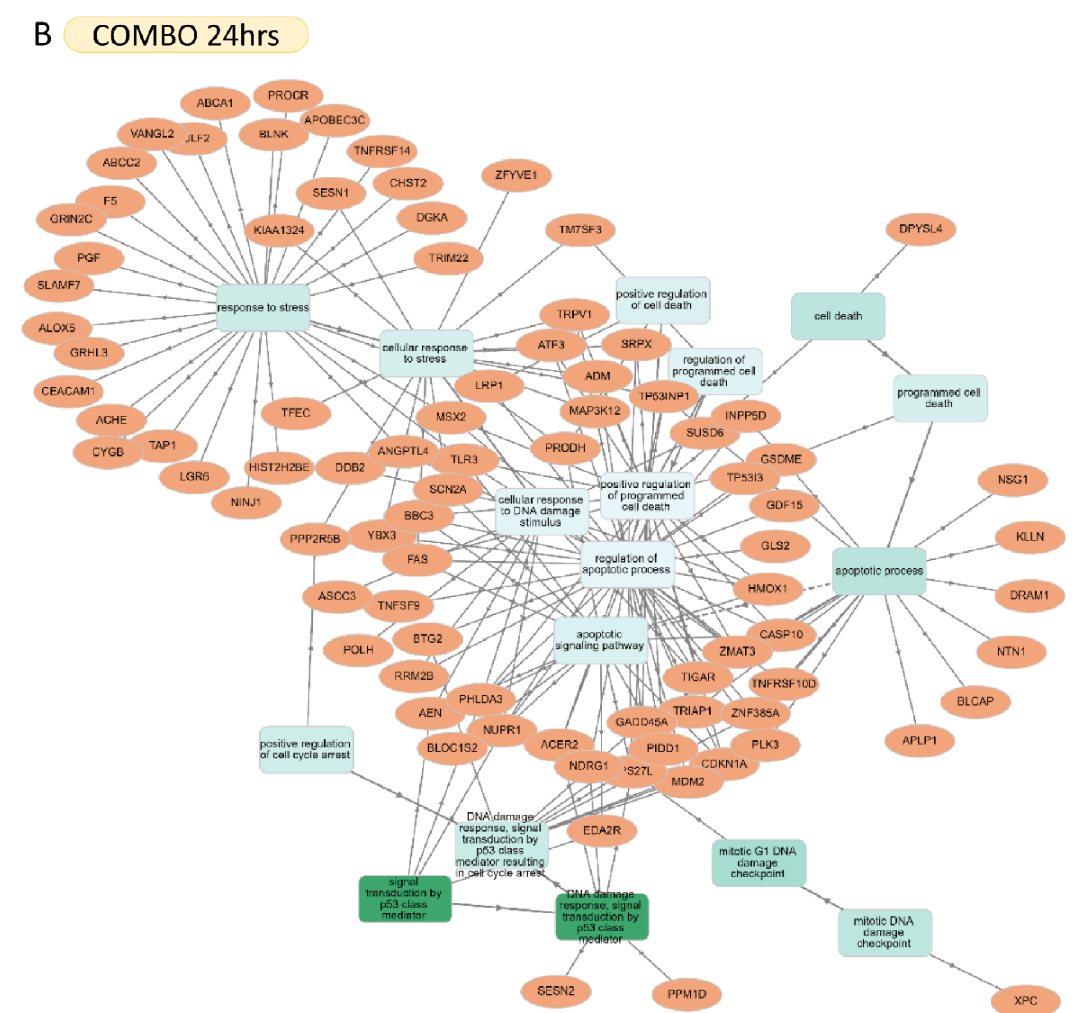
Figure 6. Comparative transcriptomic analyses between treatment with HDM201 alone and in combination with WIP1i (COMBO) for 6 and 24 h in RBE cells. ( A ) Venn diagram of all (left), upregulated (middle), and downregulated (right) differentially expressed genes, as selected according to a >2-fold change and p < 0.05. ( B ) REB was treated with HDM201 and GSK2830371 for 24 h. Seventy-seven differentially expressed genes with fold change ≥ 2 were analyzed by gene ontology (GO) enrichment analysis with Database of Immune Cell Expression (DICE) database using GO-net.